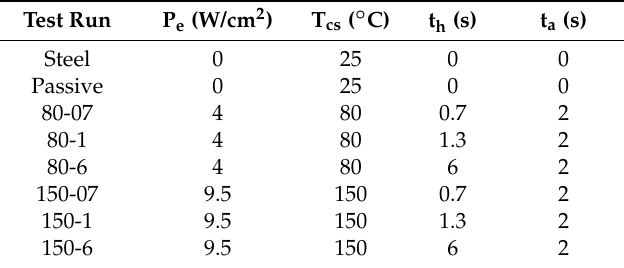
Table 1. Injection molding operating conditions.